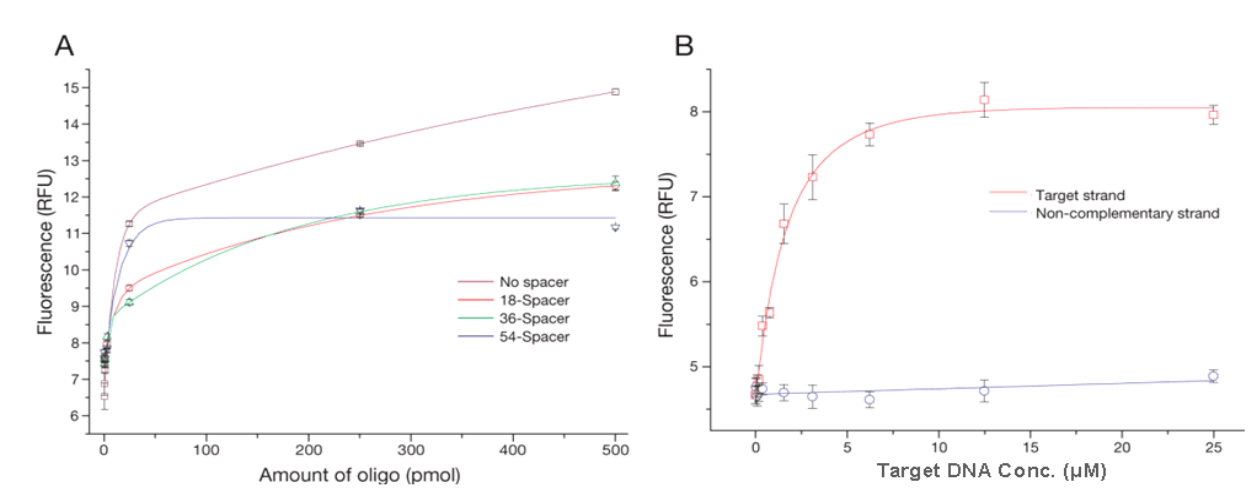
Figure 2. Oligo binding on the surface of MPs and hybridization of the MP probes and target strand. A. Different quantities of oligos with varying lengths of spacers from 0 to 54 chains were conjugated to MPs. After conjugation, they were stained with OliGreen and analyzed by flow cytometry. B. Hybridization of 100-mer target DNA and MP probes. In analogy to A, PicoGreen fluorescence was measured by flow cytometry and plotted as a function of target strand